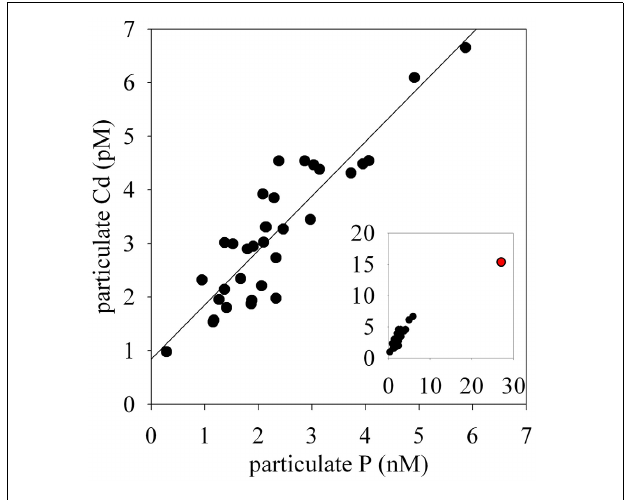
FIGURE 6 | (A) Representative photo of a typical ice core bottom sampled during this field season, showing the thick basal layer of biomass. (B) Sea ice and water column chlorophyll a profiles for Stations 1 and 3.